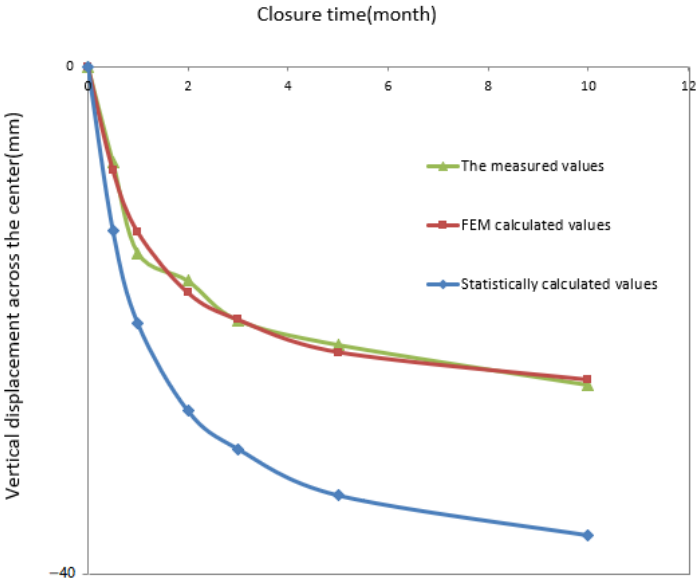
Figure 6. Comparison of vertical deformation at the mid-span of the main span.